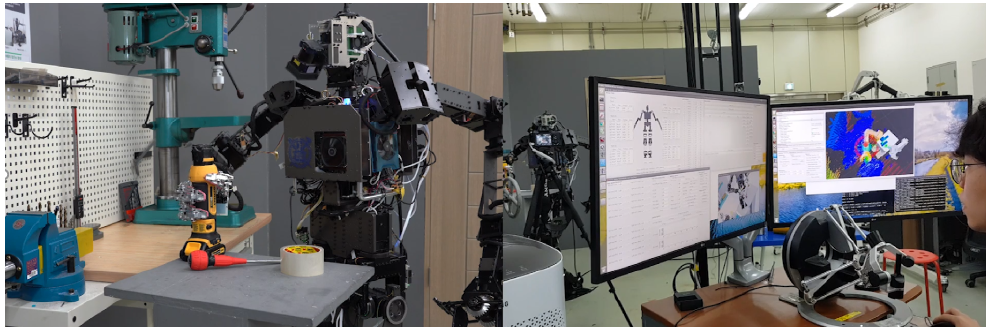
Figure 13. Manipulating objects with